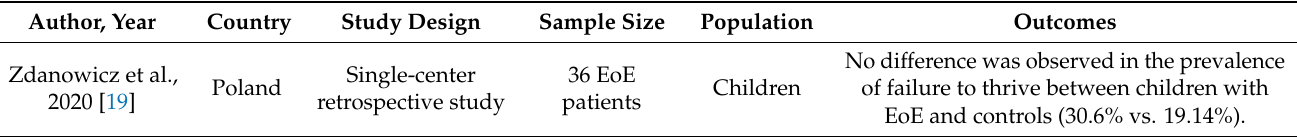
Country Study Design Sample Size Population